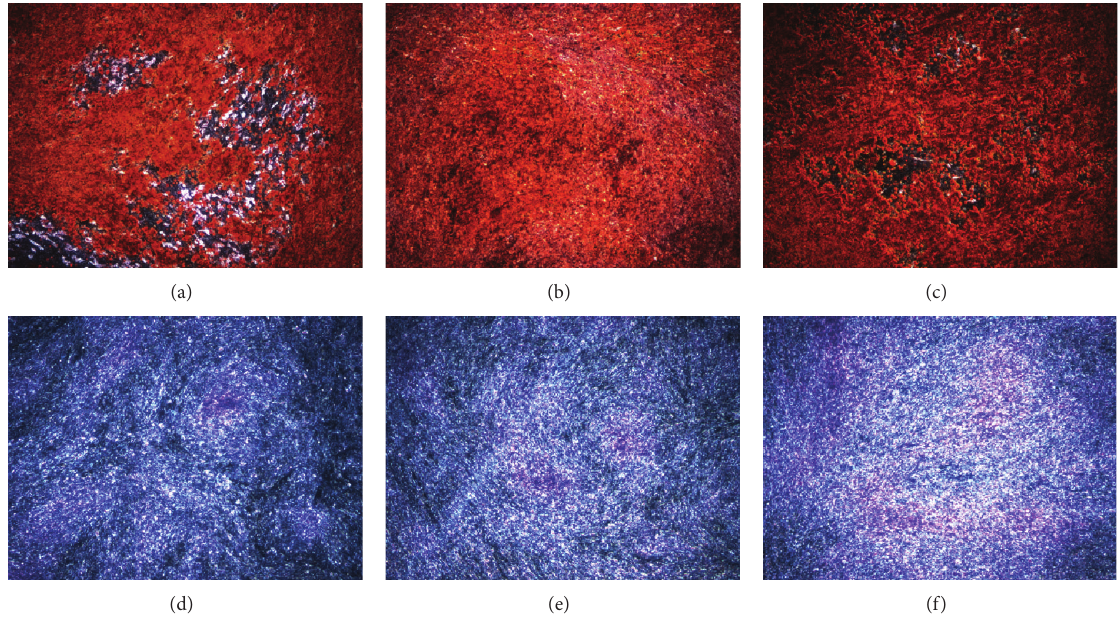
Figure 3: Representative alizarin Red staining in osteogenically differentiated ADSC ((a), (b), and (c)) and not induced control ADSC ((d), (e), and (f)) of three donors demonstrating extracellular calcium deposition as a sign of osteogenic differentiation in (a), (b), and